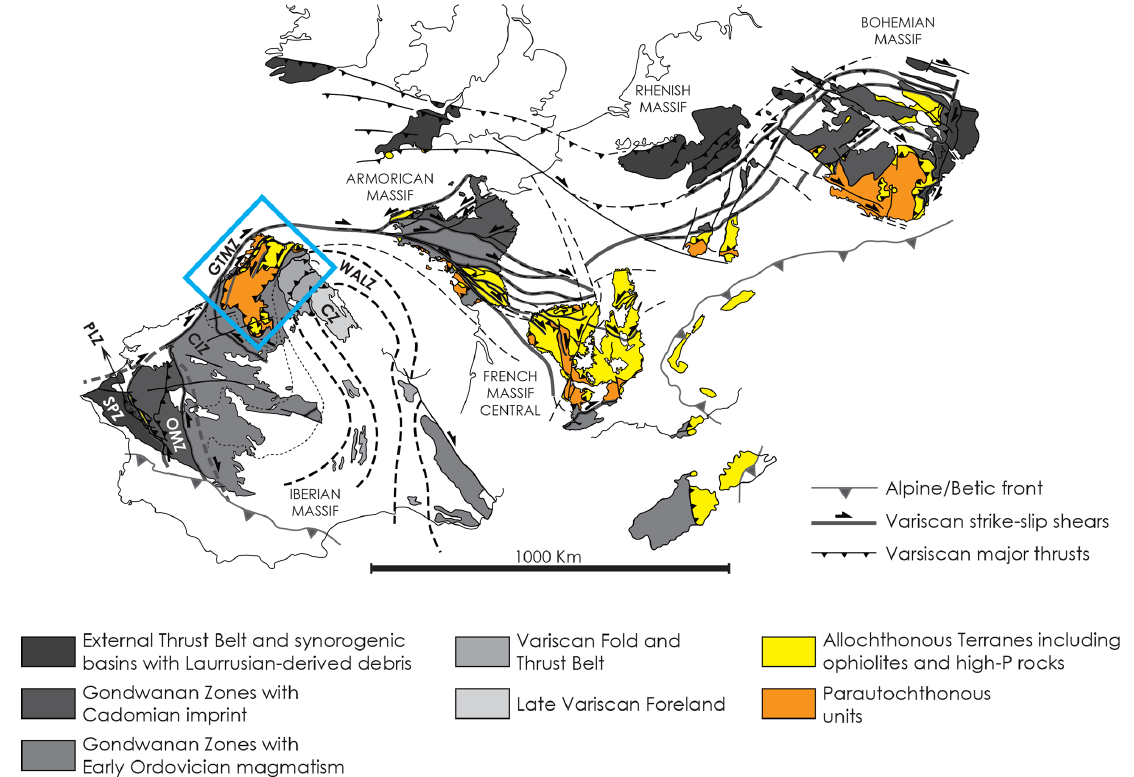
Figure 1. Map of the European Variscan belt at the end of the Carboniferous. Modified from Martínez Catalán et al. (2007). Acronyms: CZ – Cantabrian Zone; WALZ – West Asturian–Leonese Zone; GTMZ – Galicia–Trás-os-Montes Zone; CIZ – Central Iberian Zone; OMZ – Ossa-Morena Zone; PLZ – Pulo do Lobo Zone; SPZ – South Portuguese Zone. Blue rectangle area is represented in Fig.